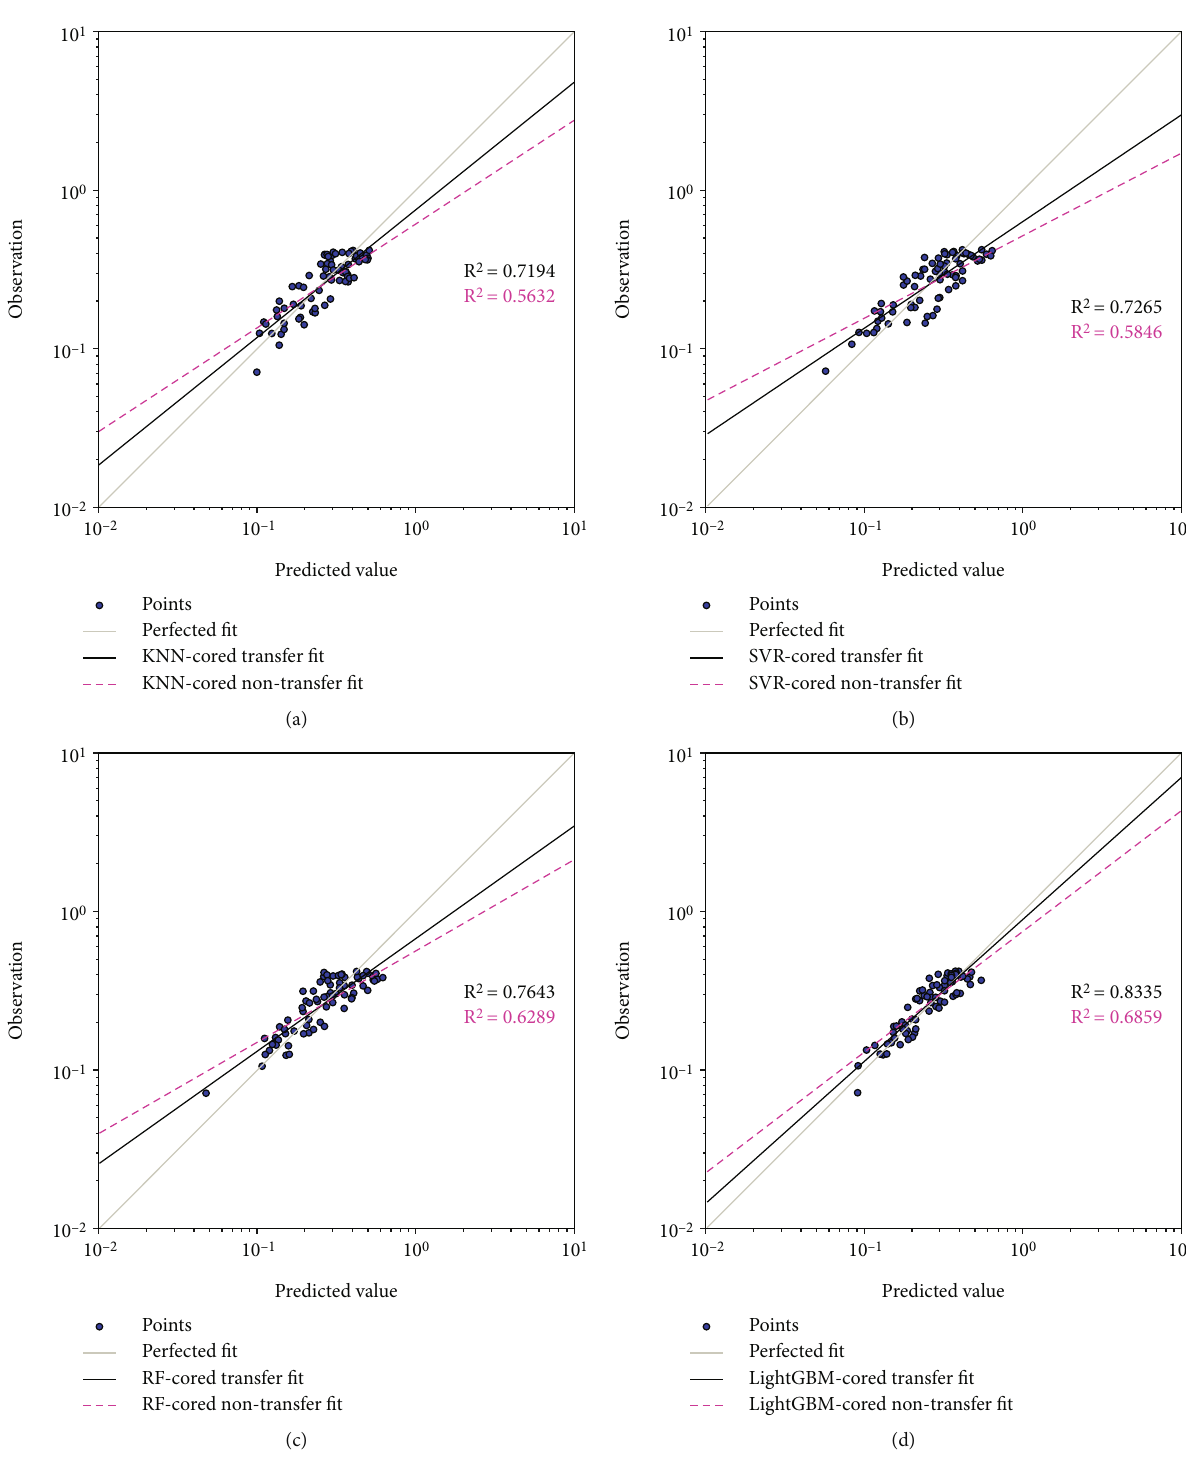
Figure 16: Fitness of permeability results provided by KNN-cored predictor (a), SVR-cored predictor (b), RF-cored predictor (c), and LightGBM-cored predictor (d) in the third experiment. KNN =k-nearest neighbors; SVR =support vector regression; RF=random forest; LightGBM=light gradient boosting machine; RMSE =root-mean-square